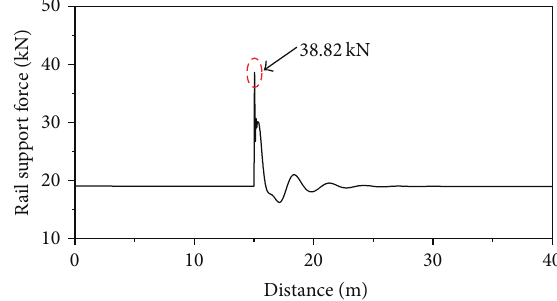
Figure 8: Wheel-rail vertical forces in time domain.